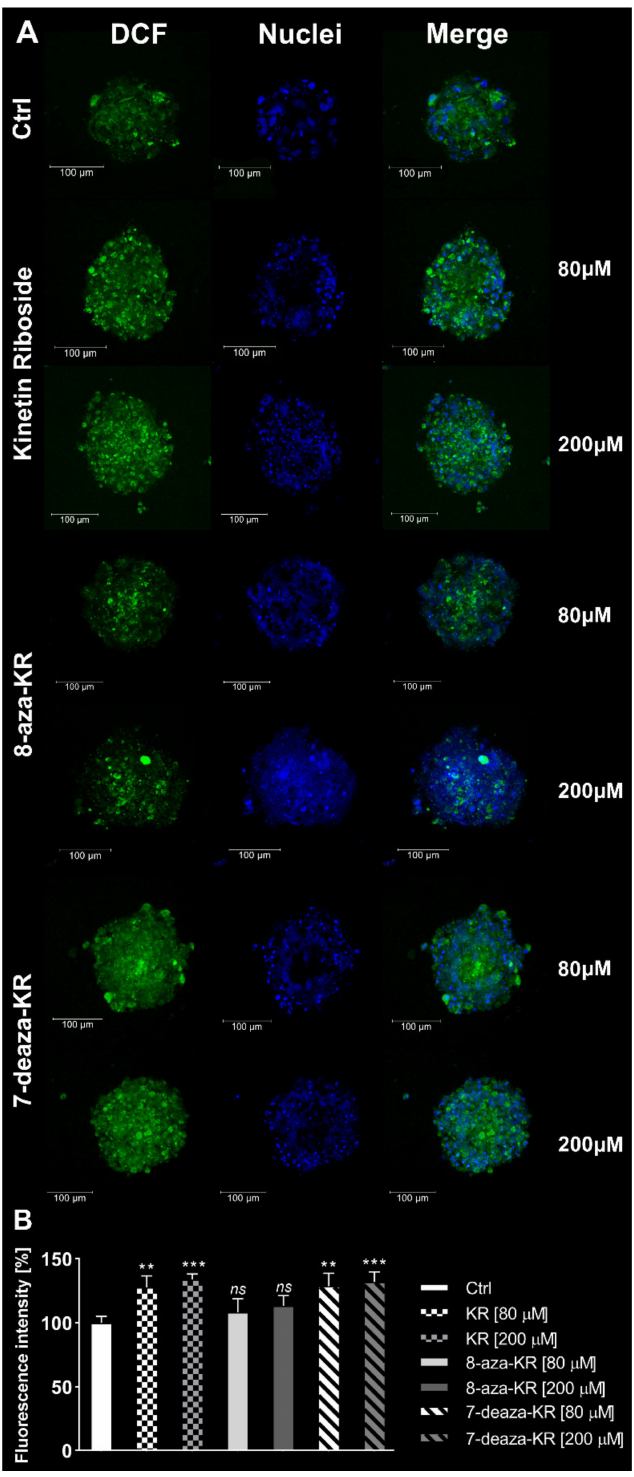
Figure 4. Cellular oxidative stress analysis in T98G 3D cell cultures. ( A ) Confocal microscopy analysis was performed after 24 h of treatment with 80 and 200 µ M of KR and 7-deazaKR. Oxidative stress was determined by H 2 DCFDA staining (ex/em: 498/505–550 nm). Nuclei were stained with Hoechst 33342 (ex/em: 405/430–480 nm). Connected images are presented on the right panel. ( B ) Analysis of the shift in the fluorescence intensity of spheroids after treatment. The results are presented as the mean fluorescence intensity ± SD of three measurements. Statistical significance (two-way ANOVA): (ns) not significant, ** p < 0.01, *** p <